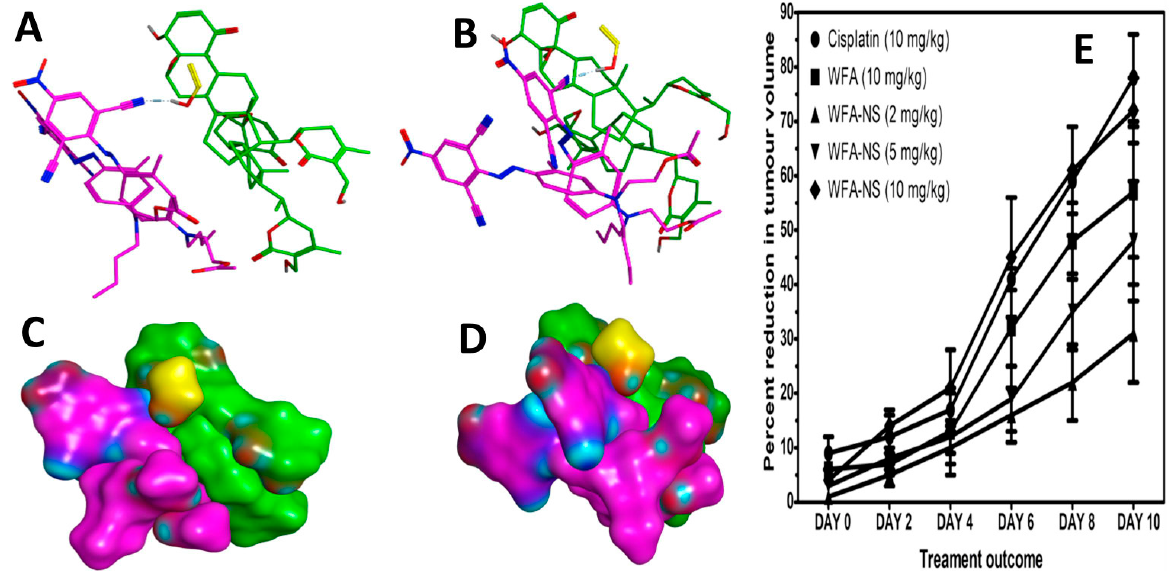
Figure 5. Molecular details of nanosponges assembly ( A , B ). The single polyvinyl alcohol (yellow stick) molecule mediates hydrogen bonding with the ethylcellulose (magenta sticks) ( A ). The results of molecular modeling studies, the bottom panels showed the MS–MS surface view of nanosponges ( C , D ). In vivo anticancer studies conducted on mice ( E ) with 10 mg/kg of Cisplatin ( ● ) 10 mg/kg of pure WFA ( ■ ), 2 mg/kg of WFA-NS ( ▲ ), 5 mg/kg of WFA-NS ( ▼ ), and 10 mg/kg of WFA-NS ( ♦ ). The WFA-NS formulation exhibited a substantially lower relative tumor volume than free WFA ( p < 0.05). Table 2. The numerical data provides percent reduction in tumor volume after giving doses (mg/kg of a